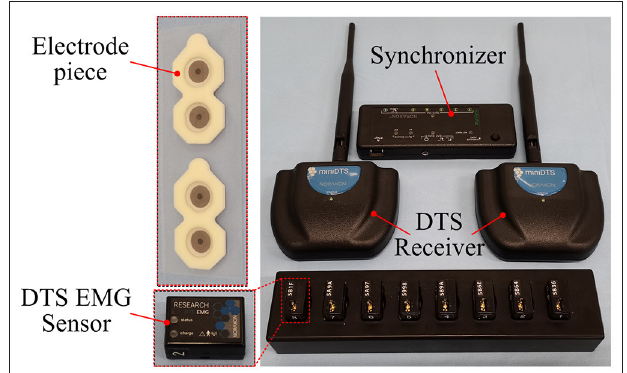
FIGURE 4 | An sEMG acquisition device.